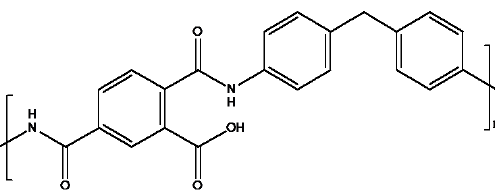
Figure 1. Structure of poly(amide-imide) Torlon ® AI-30 (Solvay Advanced Polymers LLC, Alpharetta, GA, USA) in the amic acid form.